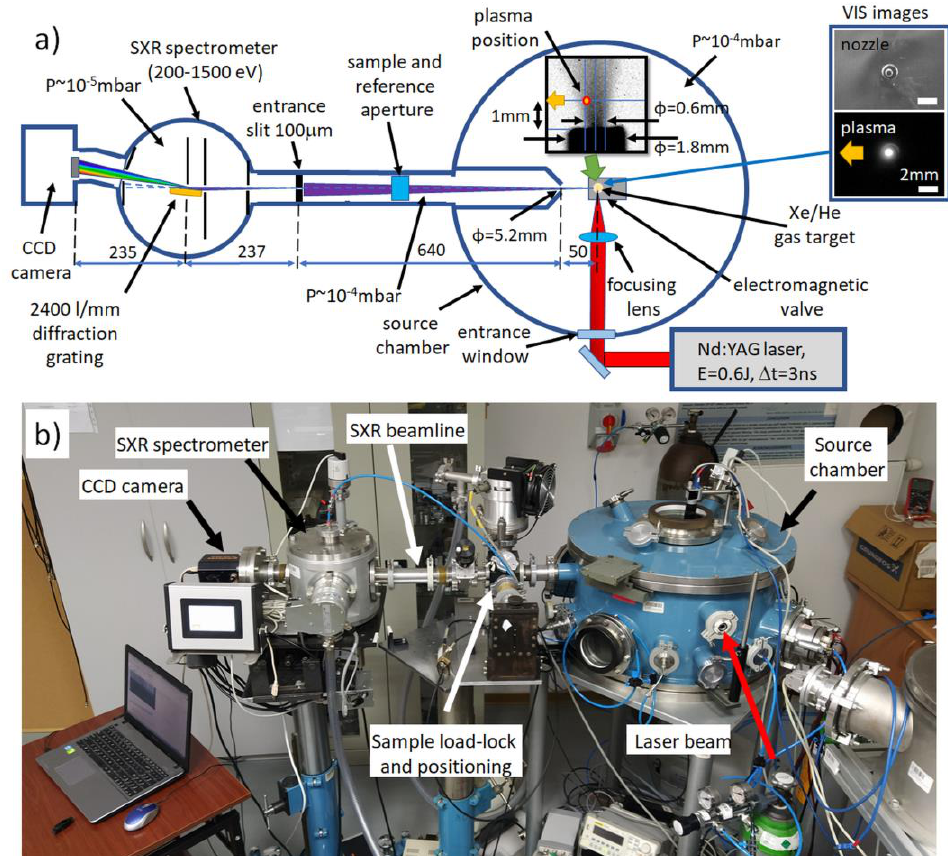
Figure 1. Schematic representation ( a ), modified from [45], and the photograph ( b ) of the experi- mental setup for transition metals NEXAFS measurements using near 1 keV from laser-produced Xe plasma, indicating major components. Orange arrows indicate the radiation propagation direction to the SXR spectrometer.